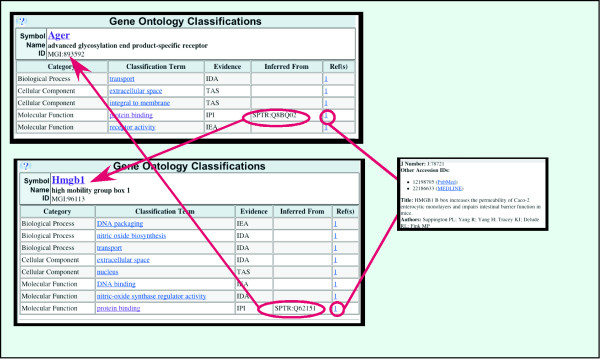
GO annotations for At and Lnk as displayed at MGI. The annotatons to GO:0005515, protein binding, are marked. The circled SPTR_ID points to the MGI marker that it is associated with. The two annotations share the same reference.